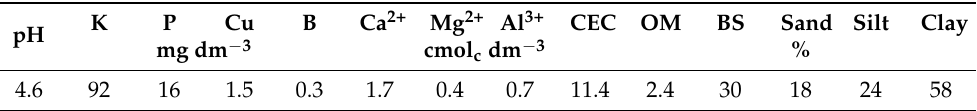
Table 6. Chemical characterization and soil texture of the experimental area at the 0–20 cm depth, before the application of the